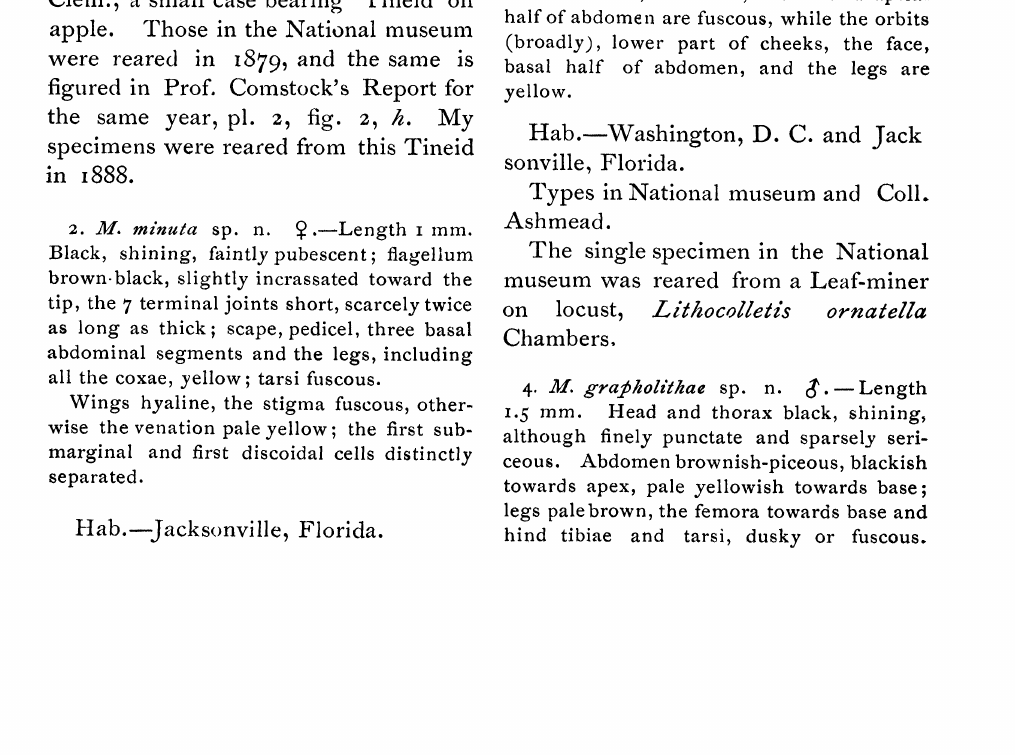
hyaline, the stigma and nervures pale brown- ish yellow, the first submarginal and first discoidal cells